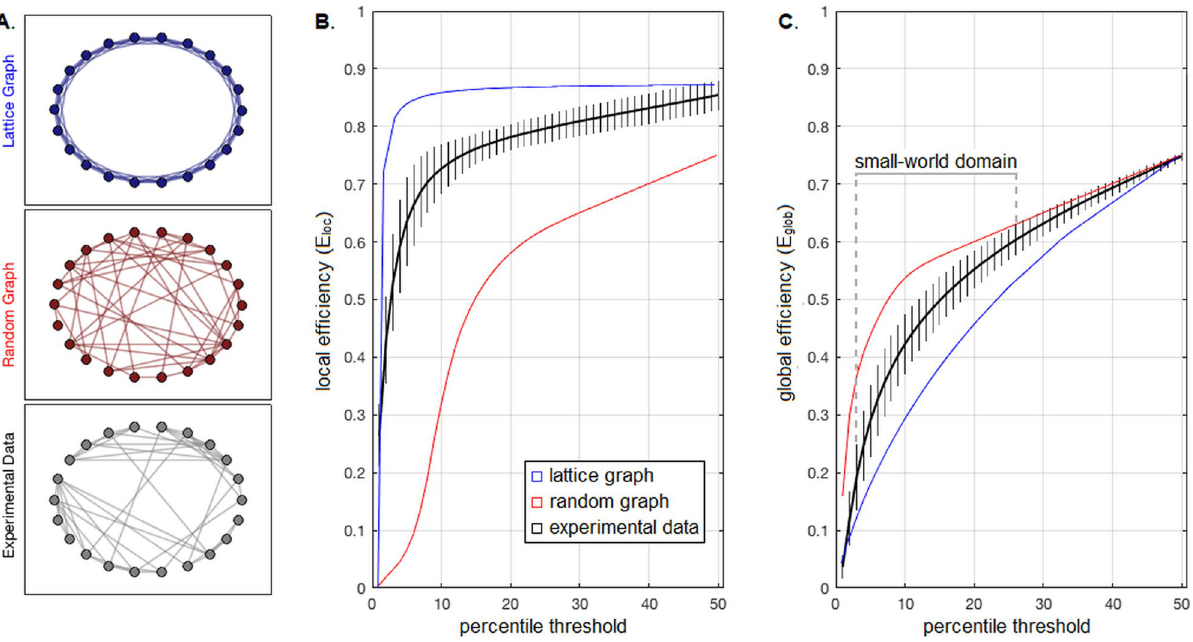
Figure 1. Characterizing network efficiency and small-world behaviour among healthy controls. ( A ) Examples of lattice and random graphs, along with a real-world graph of the experimental data from controls, plotted in circular layout. The latter graph is calculated from the average z-transformed connectivity matrix of BNA parcels in the occipital cortex (22 nodes), thresholded at P = 25% sparsity, with the former graphs generated at equivalent sizes and sparsity levels. ( B , C ) average local efficiency ( E loc ) and global efficiency ( E glob ) curves for healthy controls (black curve) along with sample 95% interval error bars, as a function of sparsity percentile threshold. The corresponding curves for lattice (blue) and random (red) graphs are also shown. The “small- world” domain is the interval in which 95% intervals do not overlap with either lattice or random graph efficiency curves for both efficiency measures ( P =